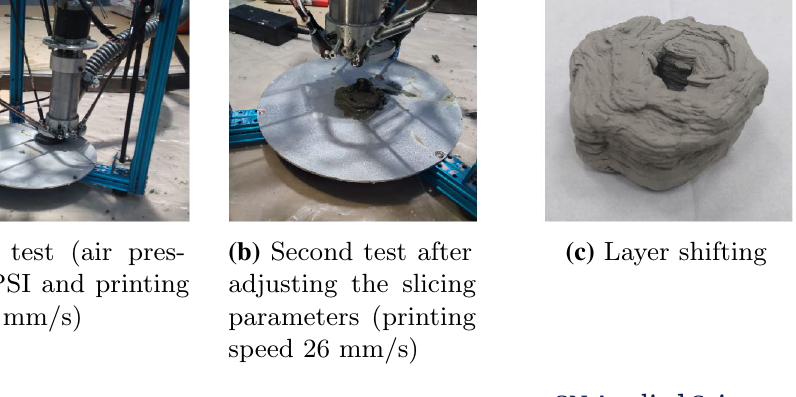
Fig. 8 Failure to print 3D ceramic